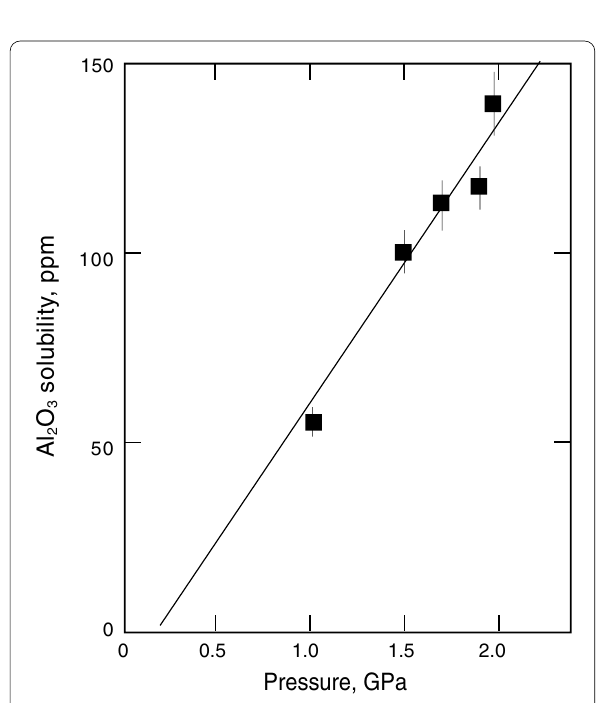
Fig. 18 Solubility of corundum (Al 2 O 3 ) in aqueous fluid in the Al 2 O 3 – H 2 O system as a function of pressure at 670–700 °C. Modified after Becker et al.